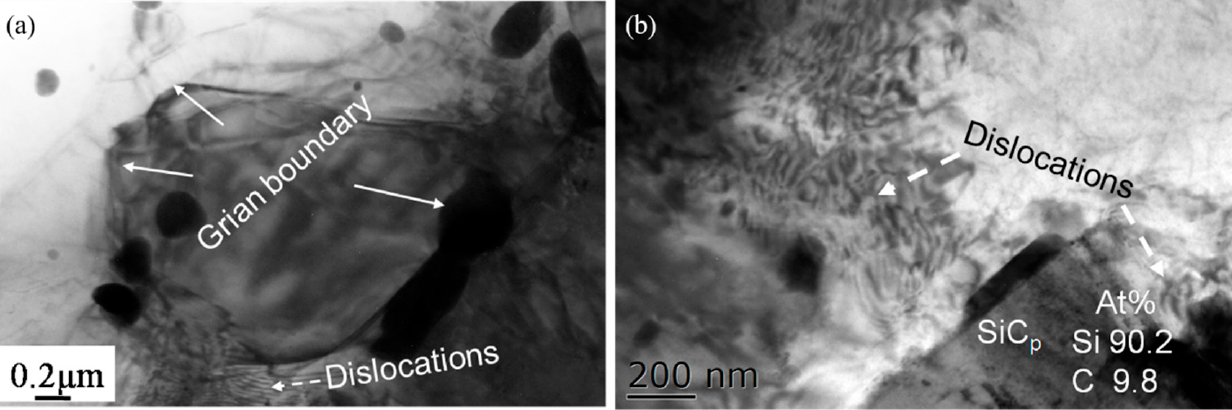
Figure 10. TEM microstructure of the SiC p /Mg-5Zn material with a compression strain of